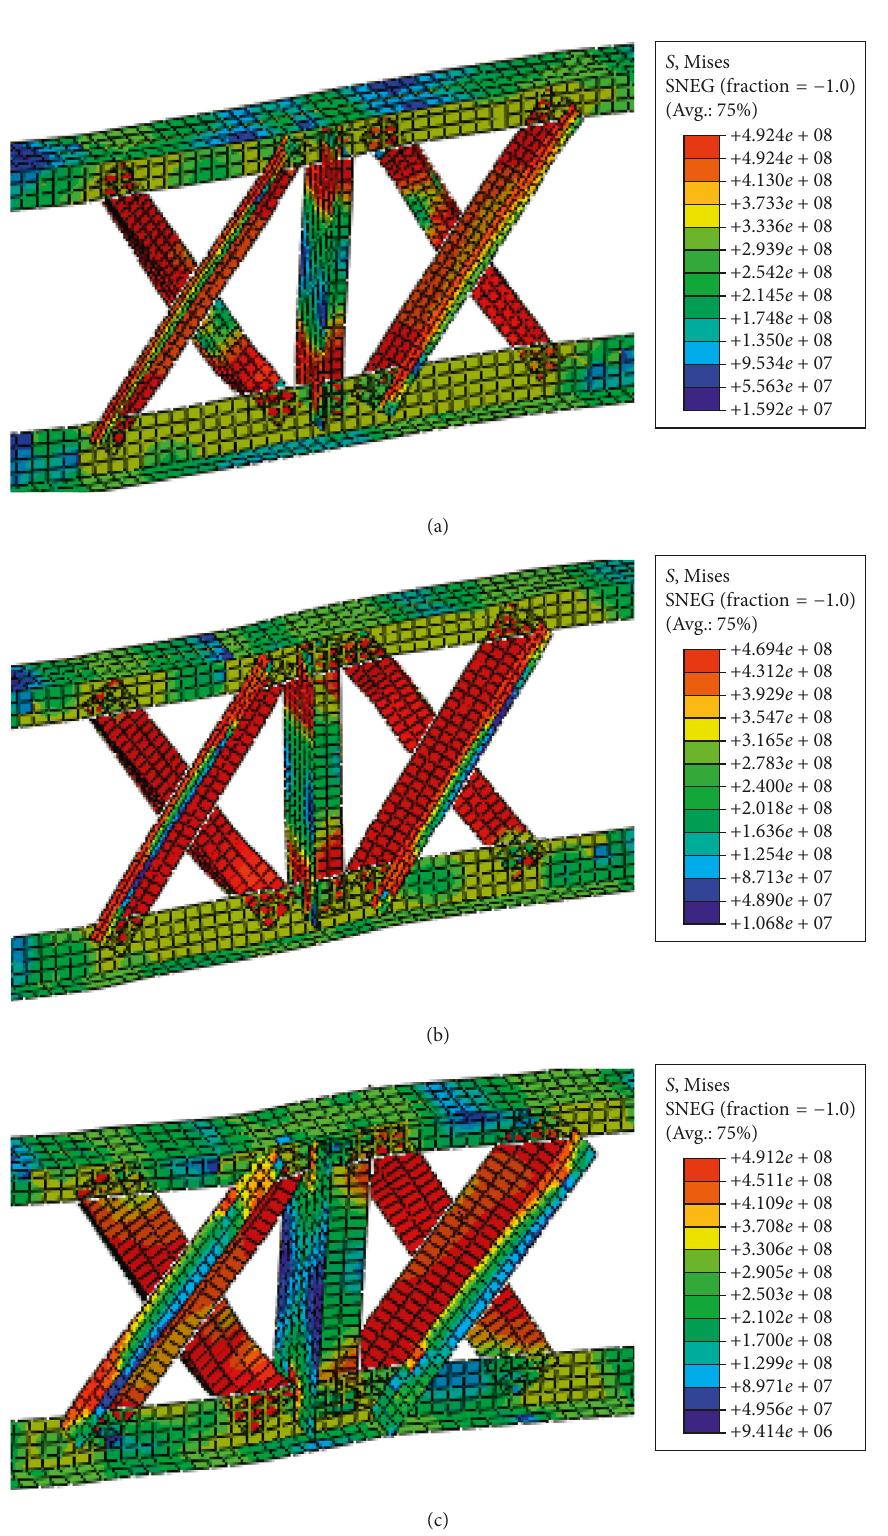
Figure 18: Deformation and Mises stress (unit: N/m 2 ) of the steel truss CBs on the 1st floor: (a) specimen WALL1; (b) specimen WALL2; (c) specimen